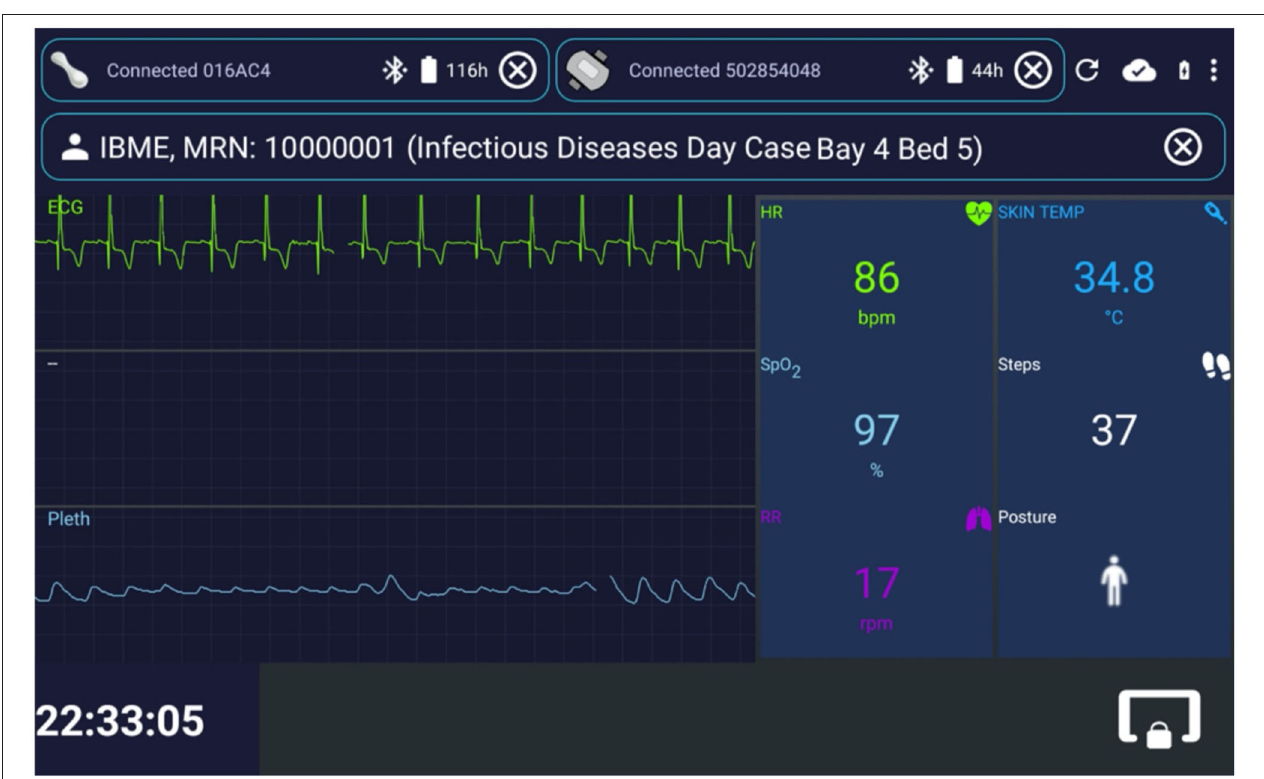
FIGURE 3 | Interface for the patient data collection app, implemented in Android Java. Exemplar test data are shown. The status of the wearable device can be observed at the top of the image, with both the VitalPatch ® and the Nonin devices in “Connected” state, and with serial numbers “016AC4” and “502854048,” respectively. The top right icons enable (from left to right): restarting the app; checking the connexion status with the back-end server; checking the charging and battery status; and entering the app settings. The patient can be unregistered by pressing the outlined “ × ” icon on the right of the patient information field. The live vital-sign and waveform data (ECG, Electrocardiogram, and Pleth, Photoplethismography) values are displayed on the right side and left side of the app, respectively. The lower right icon locks the app screen, leaving only the lower left clock displayed. In this case, the monitoring and streaming of the vital-sign data occur in the background, likely to be a less distracting mode for patients (particularly useful at night, because of the light emitted by the tablet). IBME, Institute of Biomedical Engineering; MRN, Medical Record Number; bpm, beats per minute; rpm, respirations per minute; HR, Heart Rate; RR, Respiratory Rate; TEMP, Temperature; SpO 2 , peripheral blood Oxygen